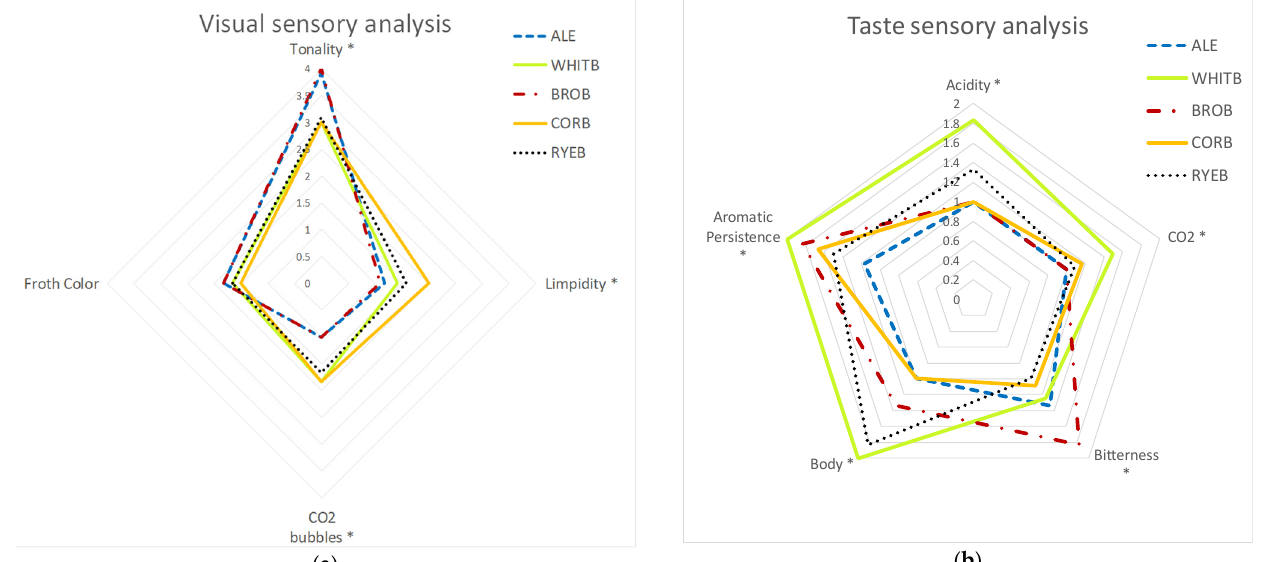
Figure 4. ( a ) Visual radar graphic; ( b ) Taste radar graphic. * Statistically significant differences ( p ‐value ≤ 0.05).